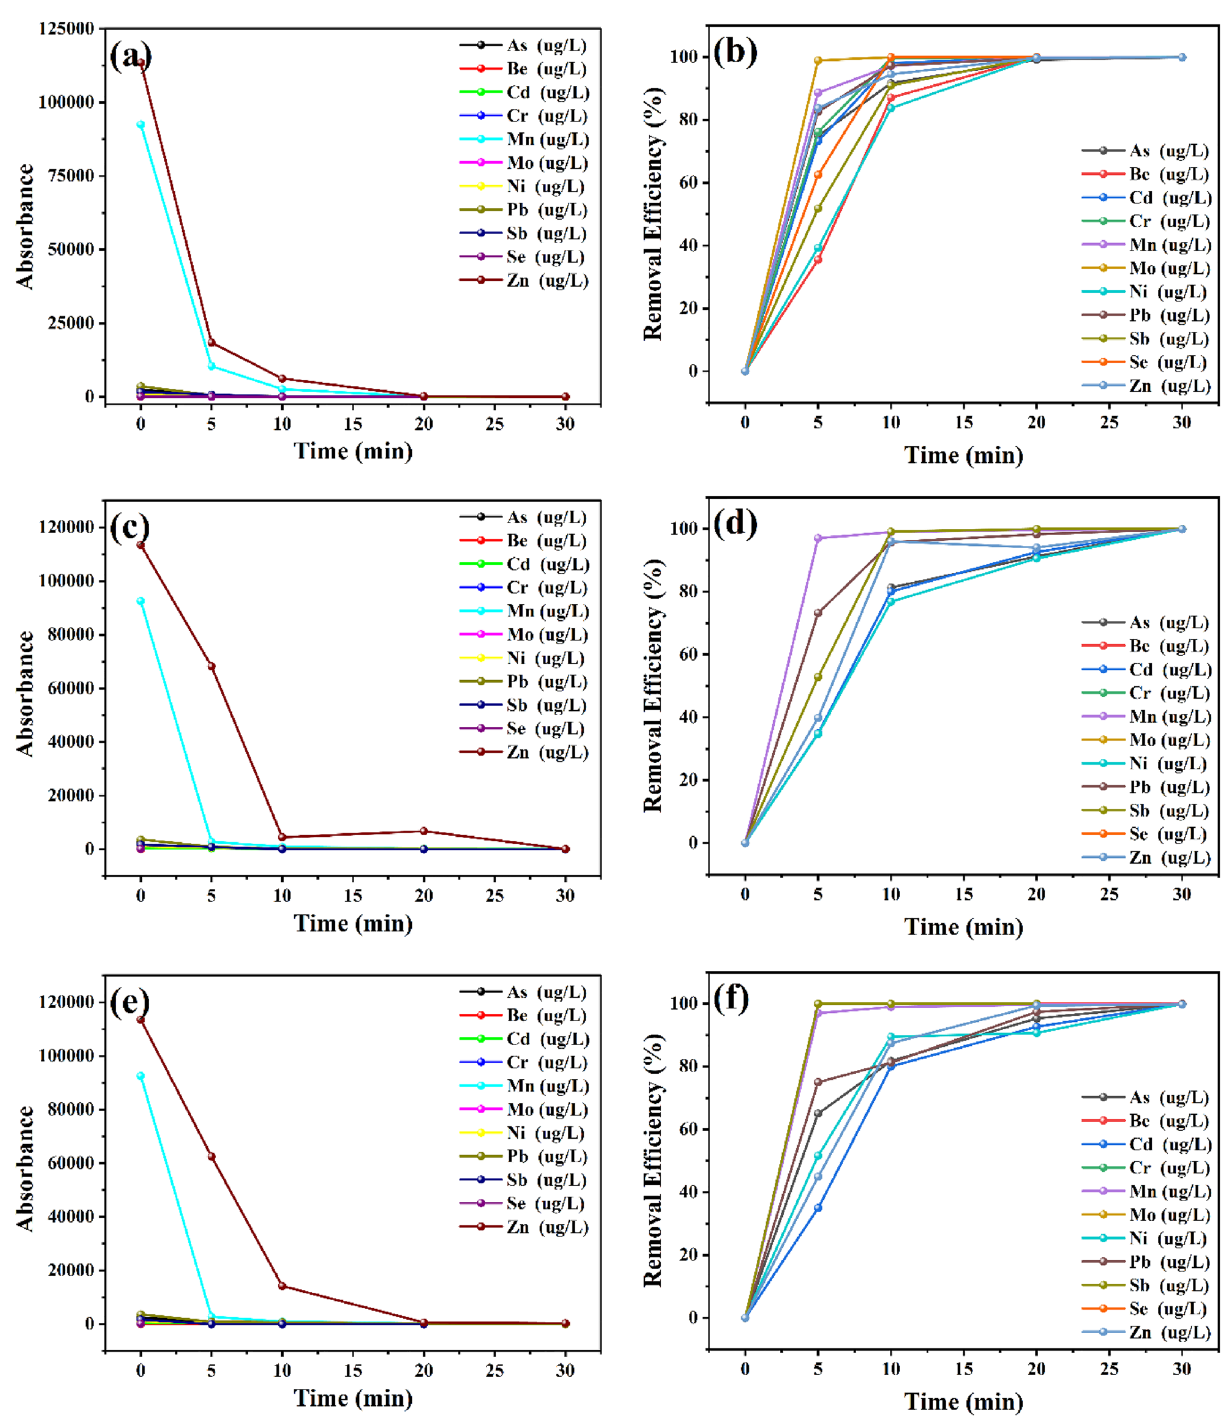
Figure 6. Time effect and efficiency rate of ( a , b ) α-Fe 2 O 3 , ( c , d ) CuO, and ( e , f ) ZnO for removal of heavy metals from the aqueous